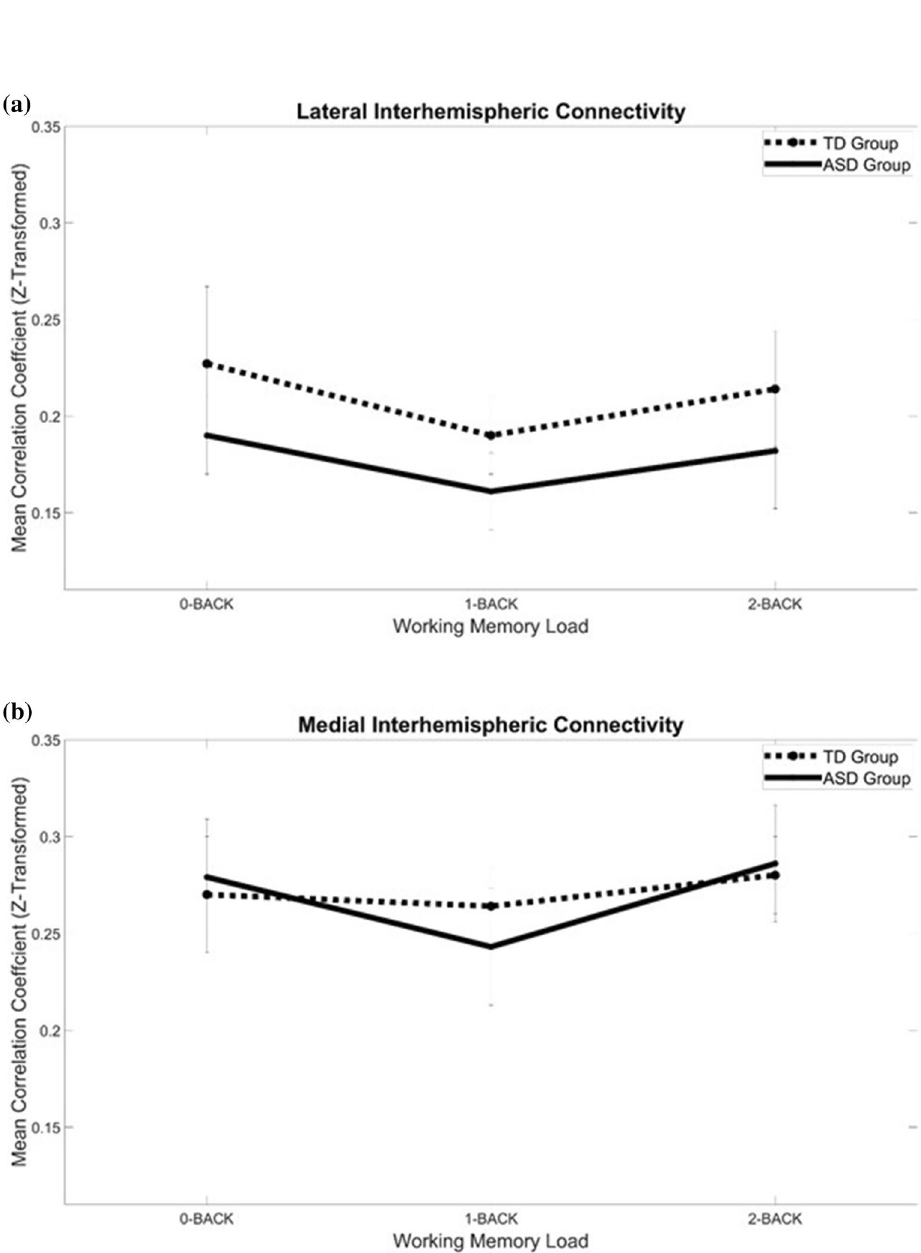
Figure 5. The effect of n-back task load on the ( a ) lateral and ( b ) medial interhemispheric functional connectivity changes in the prefrontal cortex in TD and